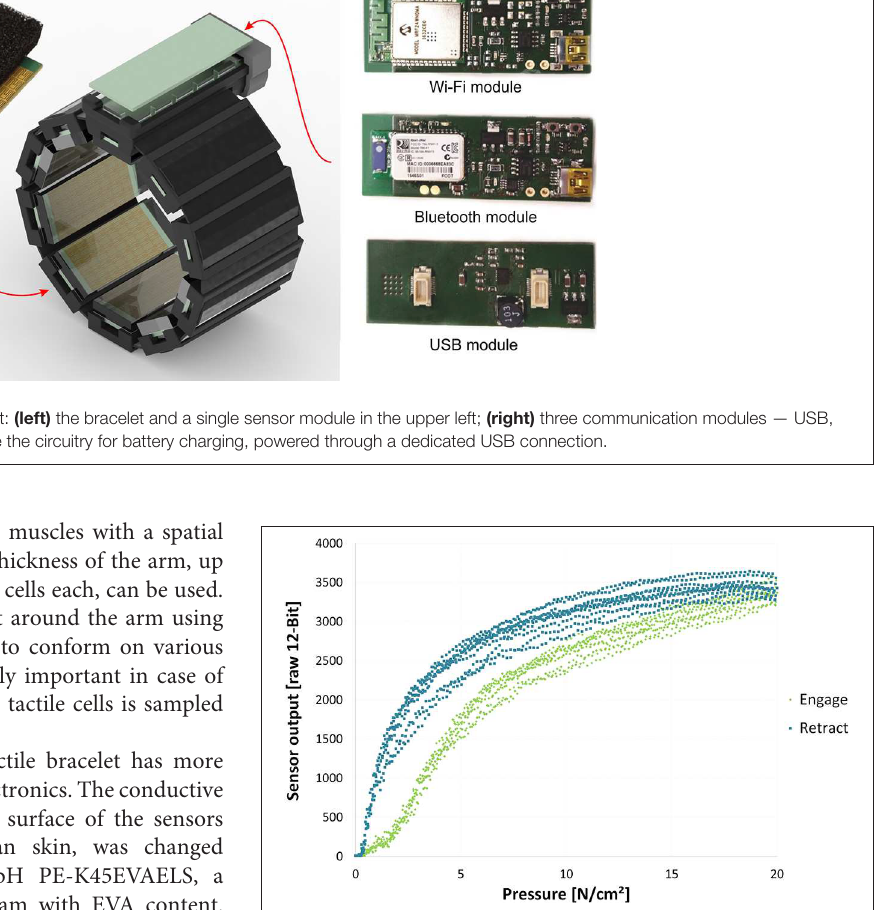
FIGURE 2 | Sensor characteristics measured over 10 trials from no contact to 20 N / cm 2 and back to no contact using the new 3 mm thick PANA Foamtec GmbH PE-K45EVAELS. The green samples are collected while pressure onto the sensor was increased whereas the blue ones are sampled during the retraction